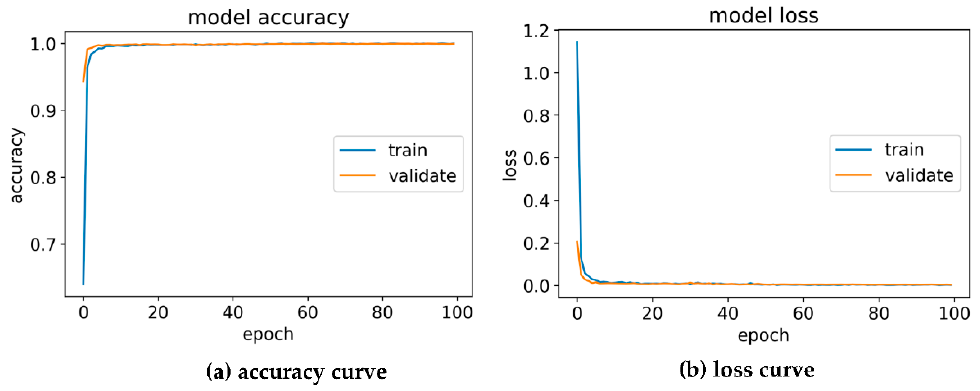
Figure 9. The accuracy curve and loss curve of the proposed DIC model in dataset 2A.